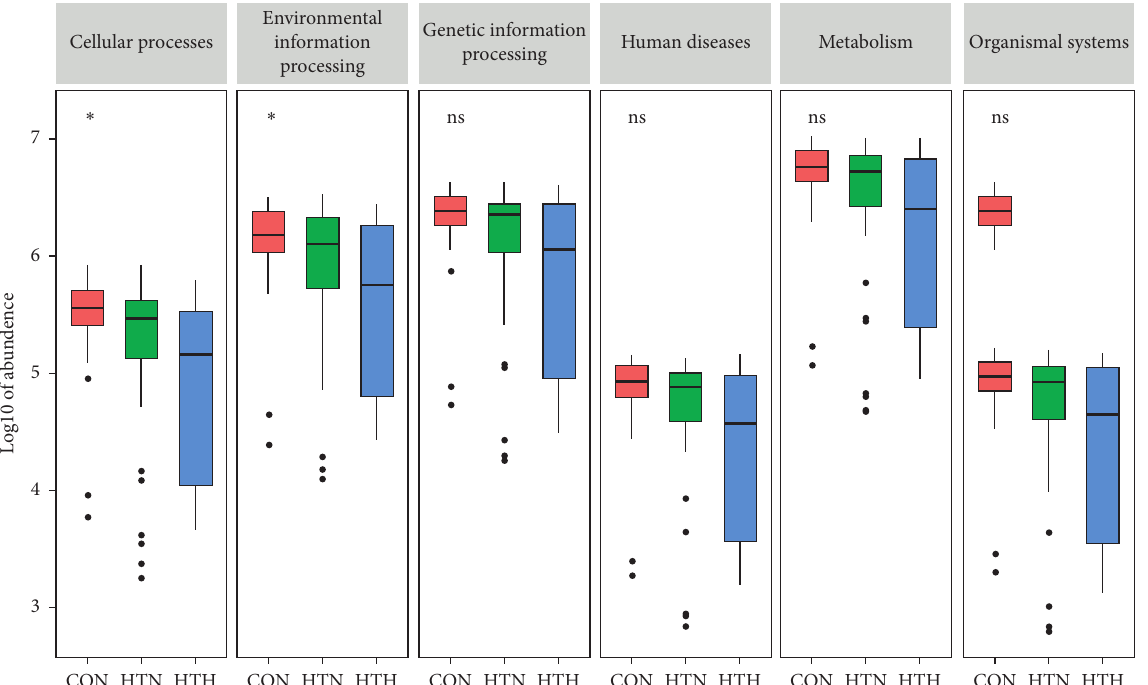
Figure 5: The possible pathways related to gut microbiota change among the three groups. The abundance of predicted genes in each predicted pathway is indicated by boxplot. ∗ P < 0 . 05 indicates